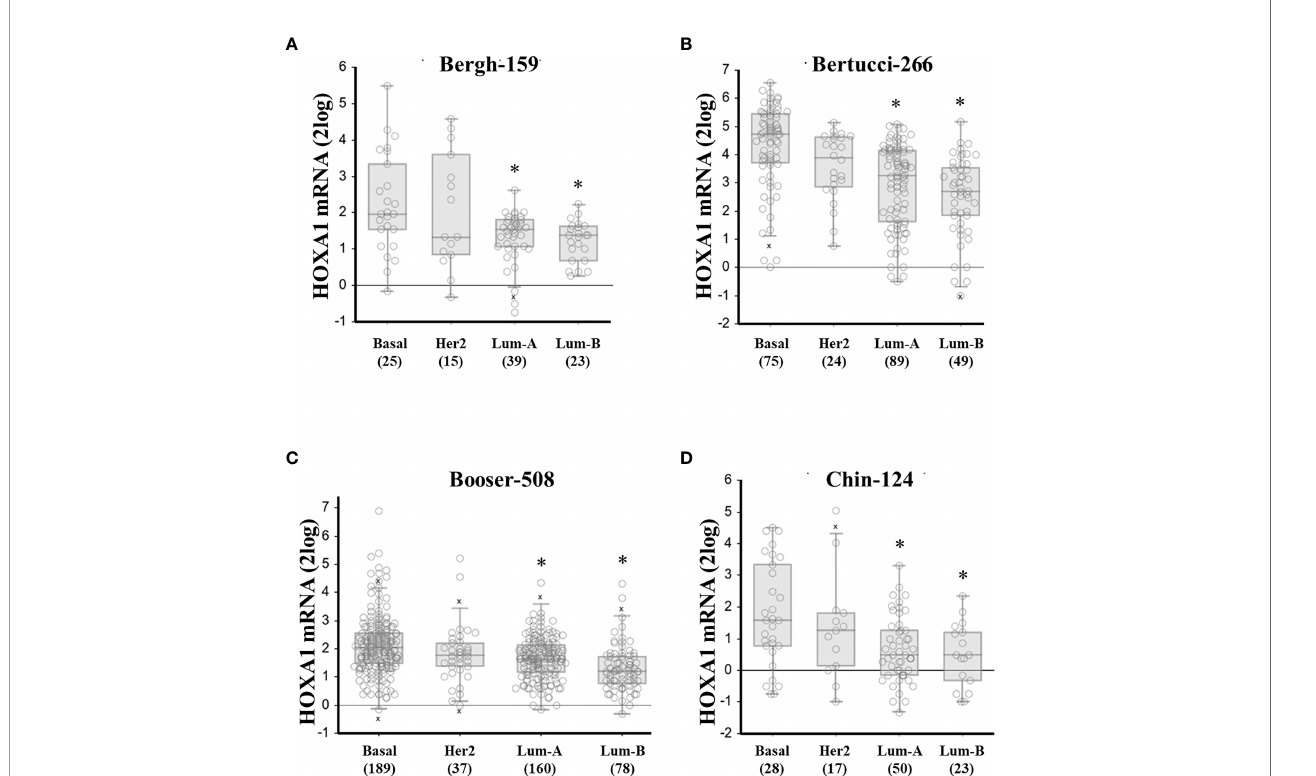
FIGURE 1 | High HOXA1 mRNA expression correlates with the basal breast cancer subtype. HOXA1 mRNA expression correlation with breast cancer molecular subtypes. Panels (A – D) represent the results from all 4 breast cancer datasets in the public domain with sample number > 100, and annotation on molecular subtype: Bergh-159, Bertucci-266, Booser-508, and Chin-124, respectively. Below the graphs are the different subtypes: basal-like (basal), HER2-overexpressing (Her2), Luminal-A (Lum-A), and Luminal-B (Lum-B), between brackets are the number of samples per subtype. mRNA expression values for the individual samples are presented as open circles, horizontal bars represent (from up to down: maximum value, [upper quartile, median value, lower quartile – boxed], and minimal value. Outlier samples (more or less than 3/2 of upper or lower quartile, respectively) are denoted by “ x ” . * denotes signi fi cant difference with the basal subtype expression (p < 0.05, Welch ’ s ANOVA with post-hoc test, signi fi cant differences found for both normal and 2log-transformed expression